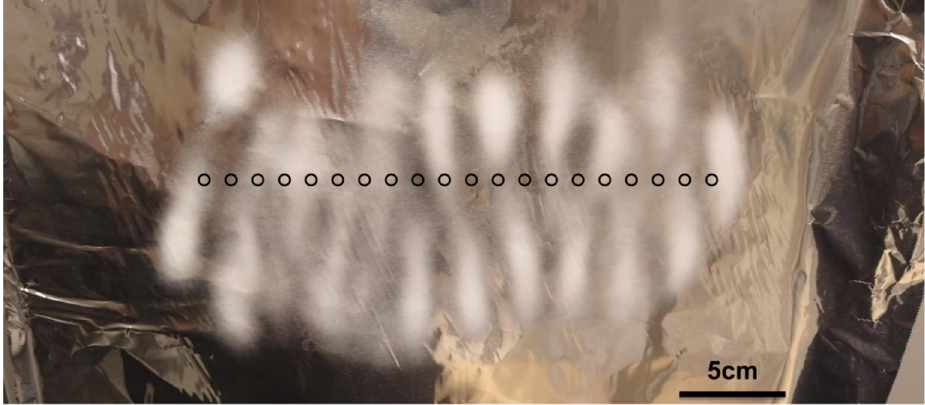
Figure 6. Deposition pattern with parallel plate auxiliary electrodes. Black circles represent needle position.